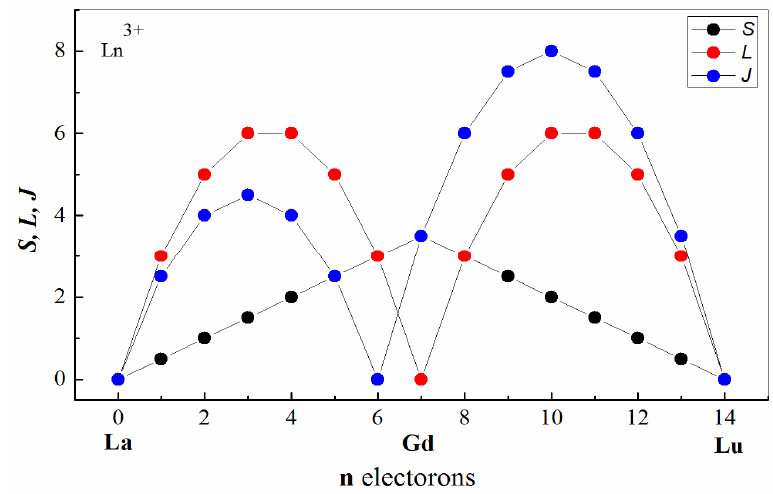
Figure 15. Variation of log K I ( K I,S ) values with total angular momentum, L , of the rare earth ions. The straight lines are drawn for visual impacts only.